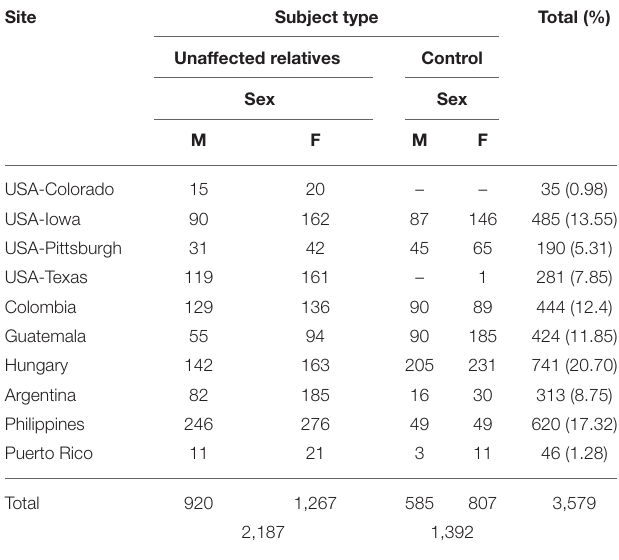
TABLE 1 | POFC Cohort (1,505 male, 2,074